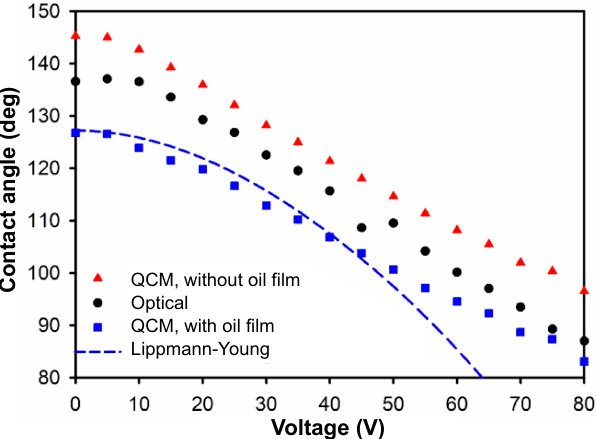
Figure 4. Contact angle of a 3- μ L water droplet in oil varied with EWOD and measured with a QCM and an optical goniometer.